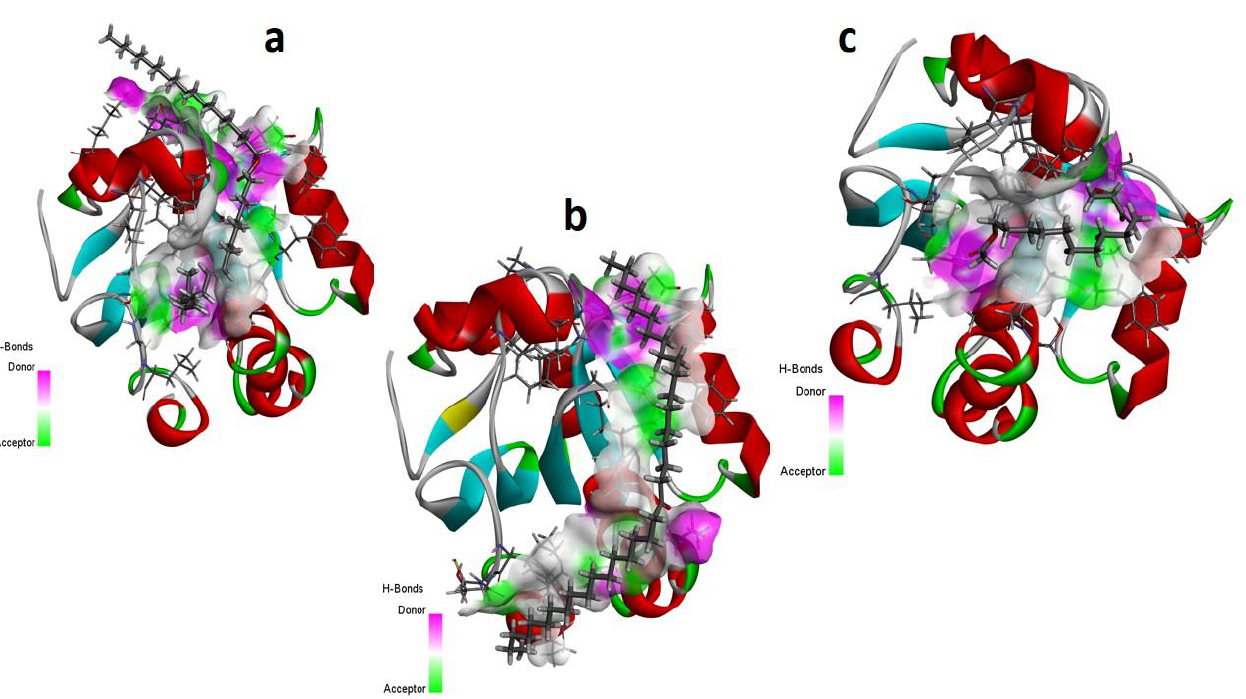
Figure 7. Interaction plot of top three scored docked ligands CID_ 22287839 ( a ), CID_10440 ( b ), and